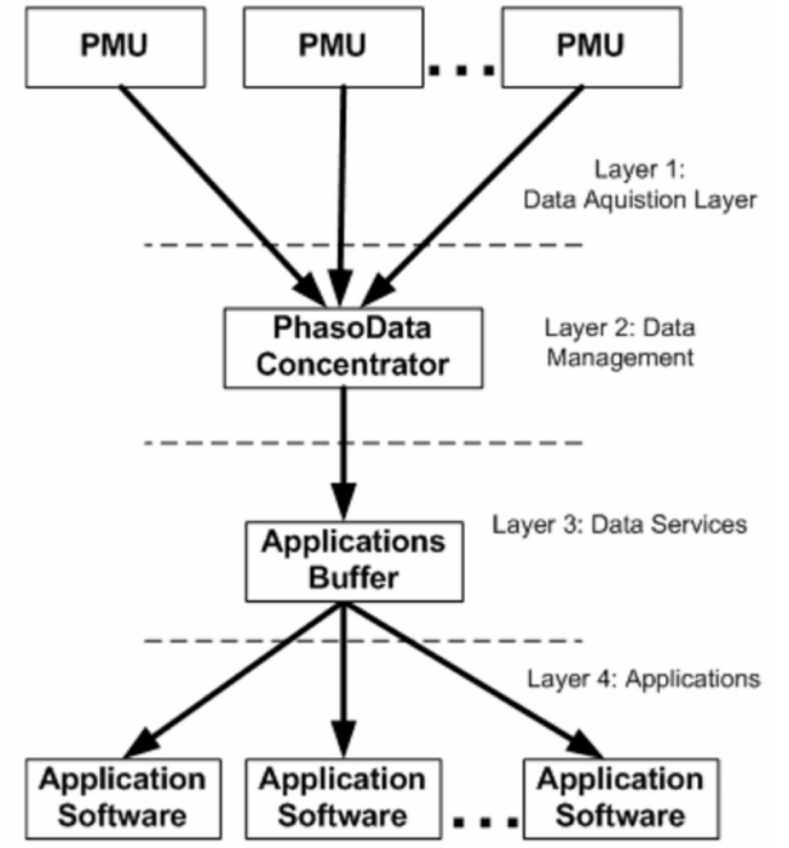
Figure 3. Illustration of the layer and components of